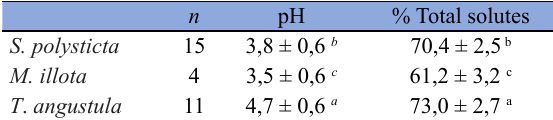
Table 2. Main chemical parameters of samples (n) of honey from S. polysticta, M. illota. and T. angustula (one day after harvest; conservation at 4 ° C).